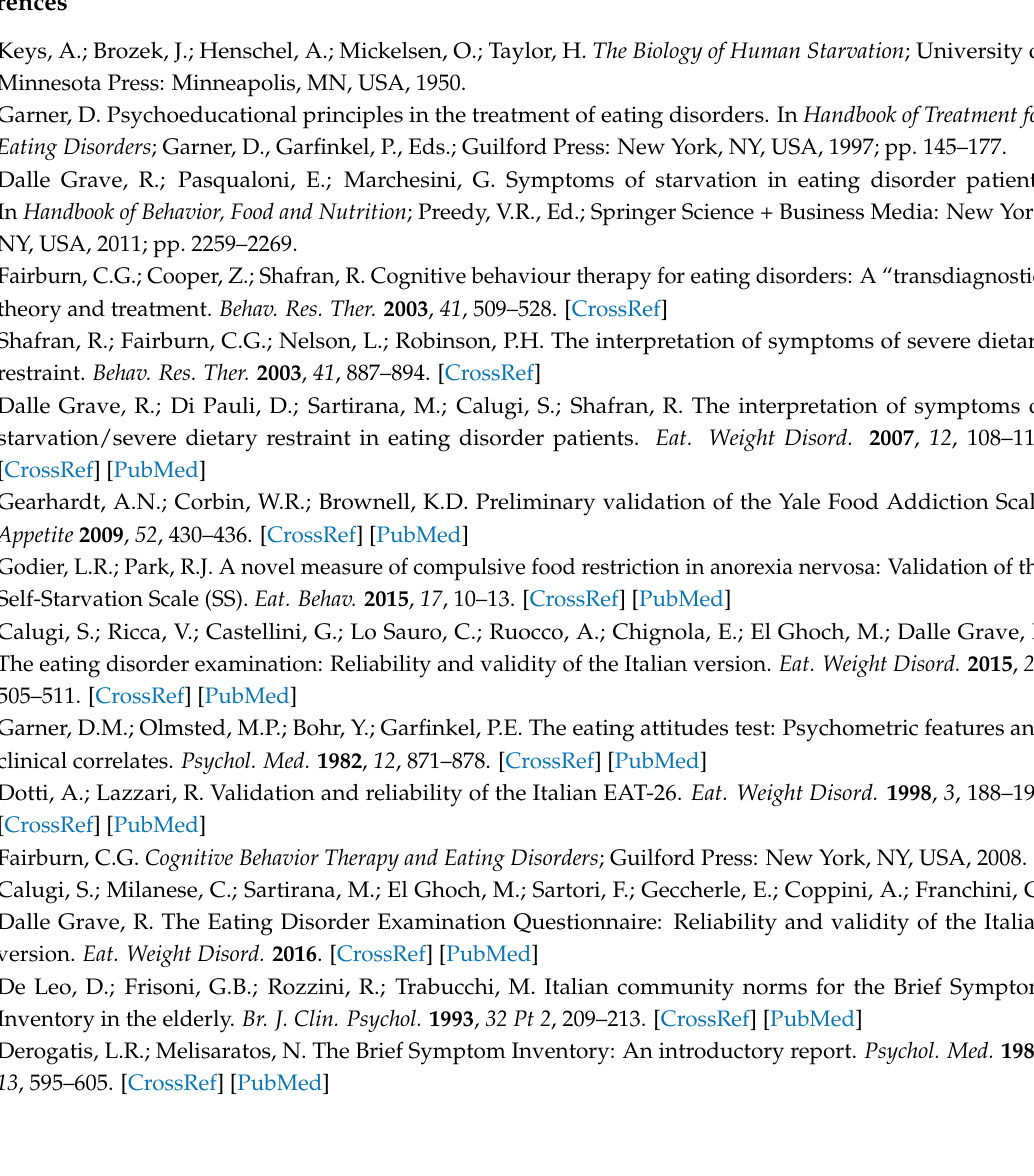
Table S1: 16-Item Starvation Symptom Inventory: means (standard deviations), eigenvalues, percentages of variance, factor loadings, and item–total correlations in the anorexia nervosa sample, Table S2: Starvation Symptom Inventory